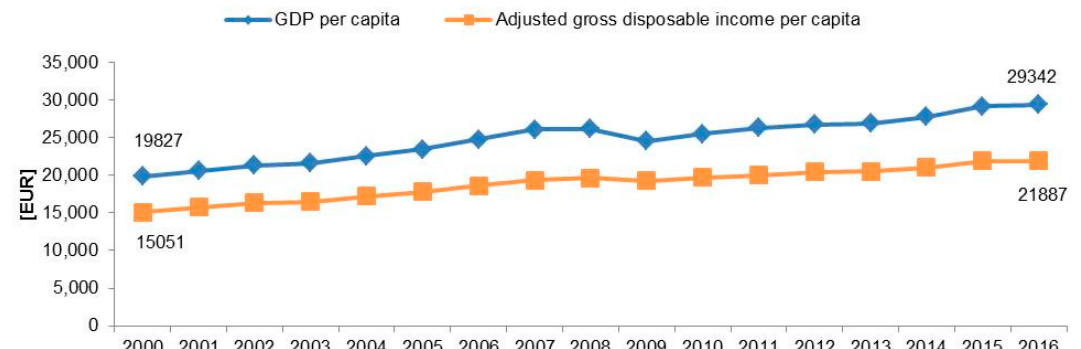
Figure 9. Adjusted gross disposable income per capita and Gross Domestic Product (GDP) per capita at current market prices in the EU-28, 2000–2016. Source: Eurostat.